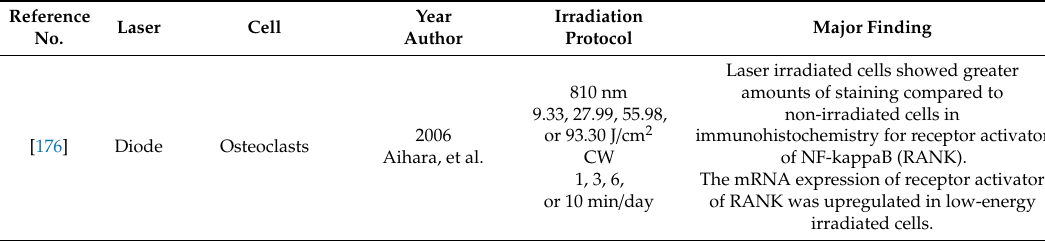
Table 8. Summary of the e ff ects of laser irradiation on